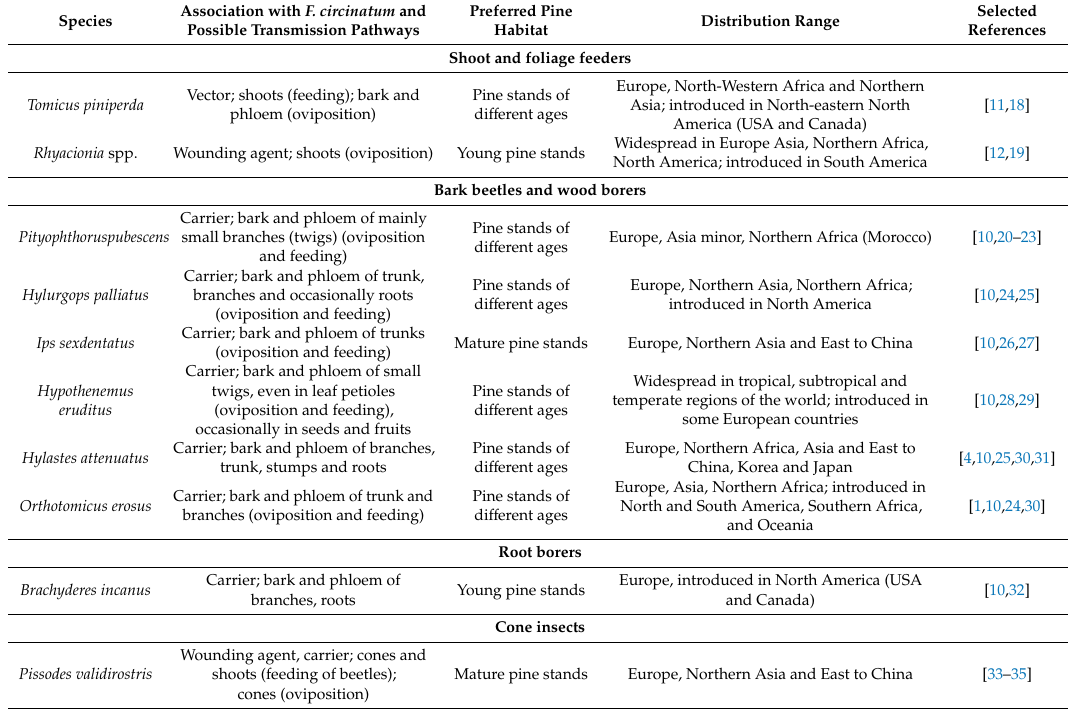
Table 1. Ecological characteristics and distribution of insects associated with Fusarium circinatum in Europe considered as vectors, carriers or wounding